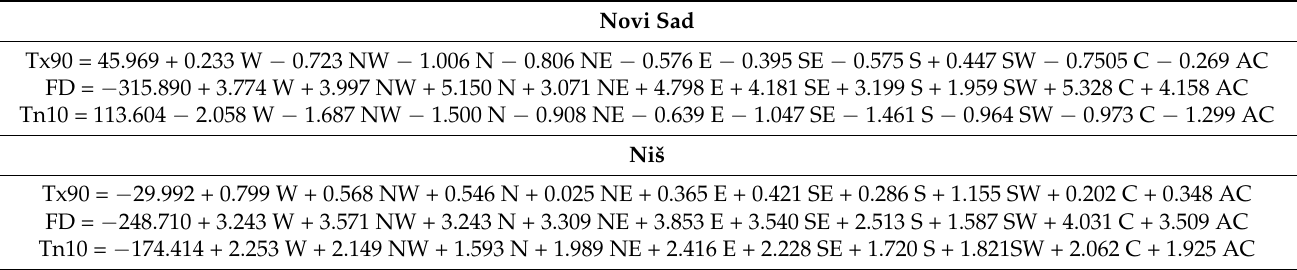
Table 11. Multiple linear regression equations for Novi Sad (northern Serbia) and Niš (southern Serbia) in winter. Novi